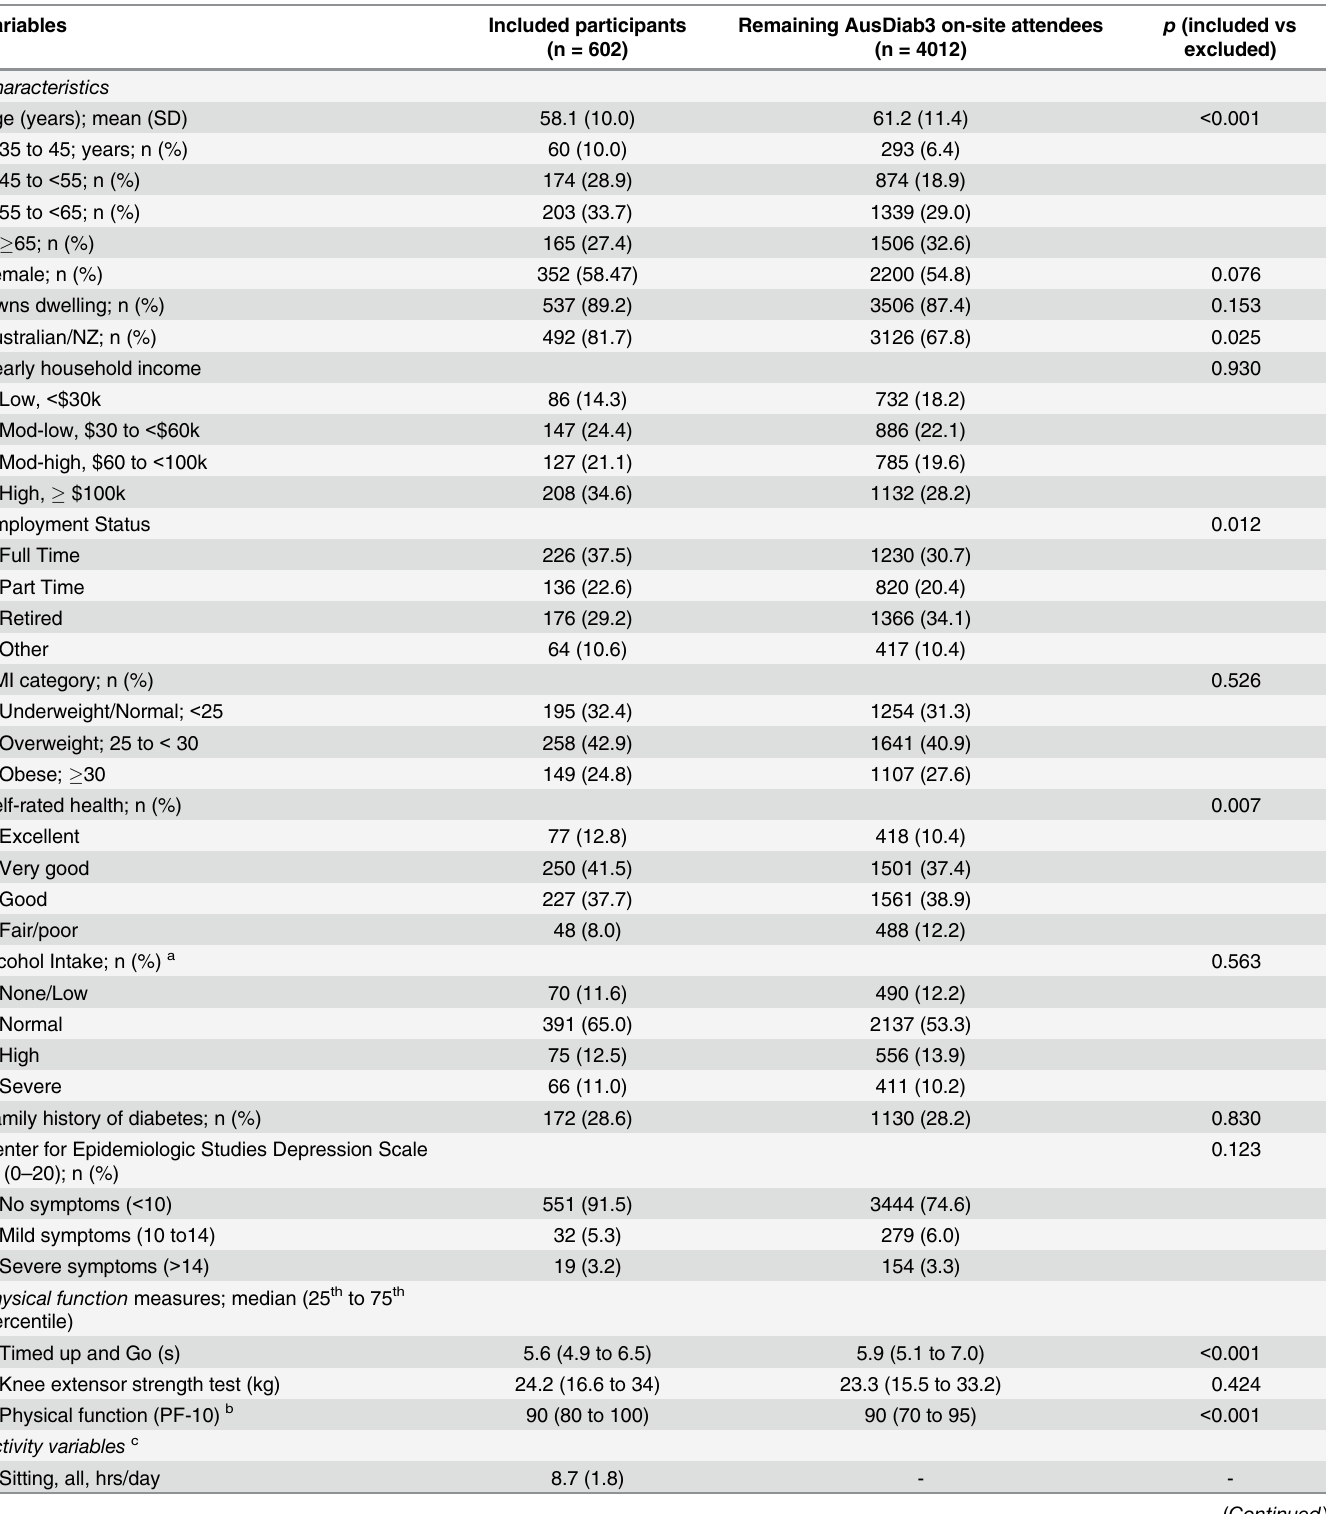
Table 1. Characteristics of AusDiab 2011/12 included participants (n = 602 in the monitor subsample with relevant data) and remaining testing site attendees (n = 4012 Australian